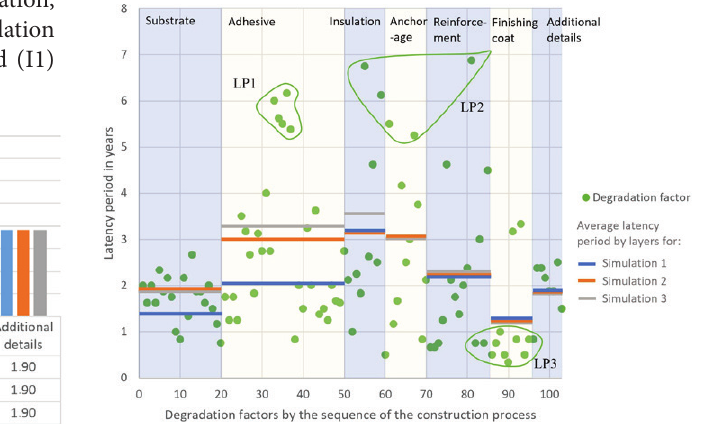
Figure 3. The average latency period by layer